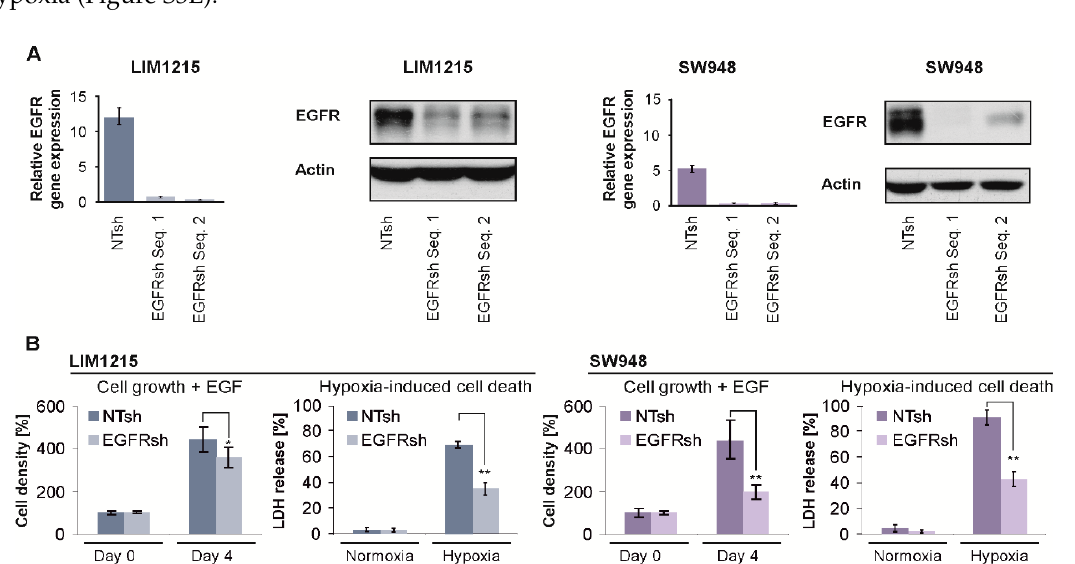
Figure 3. Generation and characterization of EGFR gene-suppressed colon carcinoma cells. ( A ) LIM1215 and SW948 cells were transduced with a lentivirus to express a non-targeting control shRNA (NTsh) or either of two shRNA sequences targeting EGFR (EGFRsh Seq. 1 and 2). Gene suppression was verified by qPCR (left, n = 3, mean ± SD) and immunoblot (right), the uncropped immunoblot figure in Figure S7. ( B ) LIM1215 and SW948 NTsh and EGFRsh (Seq. 1) cells were grown in serum-free medium supplemented with 10 ng/mL epidermal growth factor (EGF) for four days. Cell density was quantified by CV staining (left, relative to day 0, n = 5, mean ± SD, * p < 0.05, ** p < 0.01). In parallel, cells were incubated in serum-free medium containing 2 mM glucose under normoxic or hypoxic conditions. Cell death was measured by LDH release (right, n = 4, mean ± SD, ** p < 0.01).